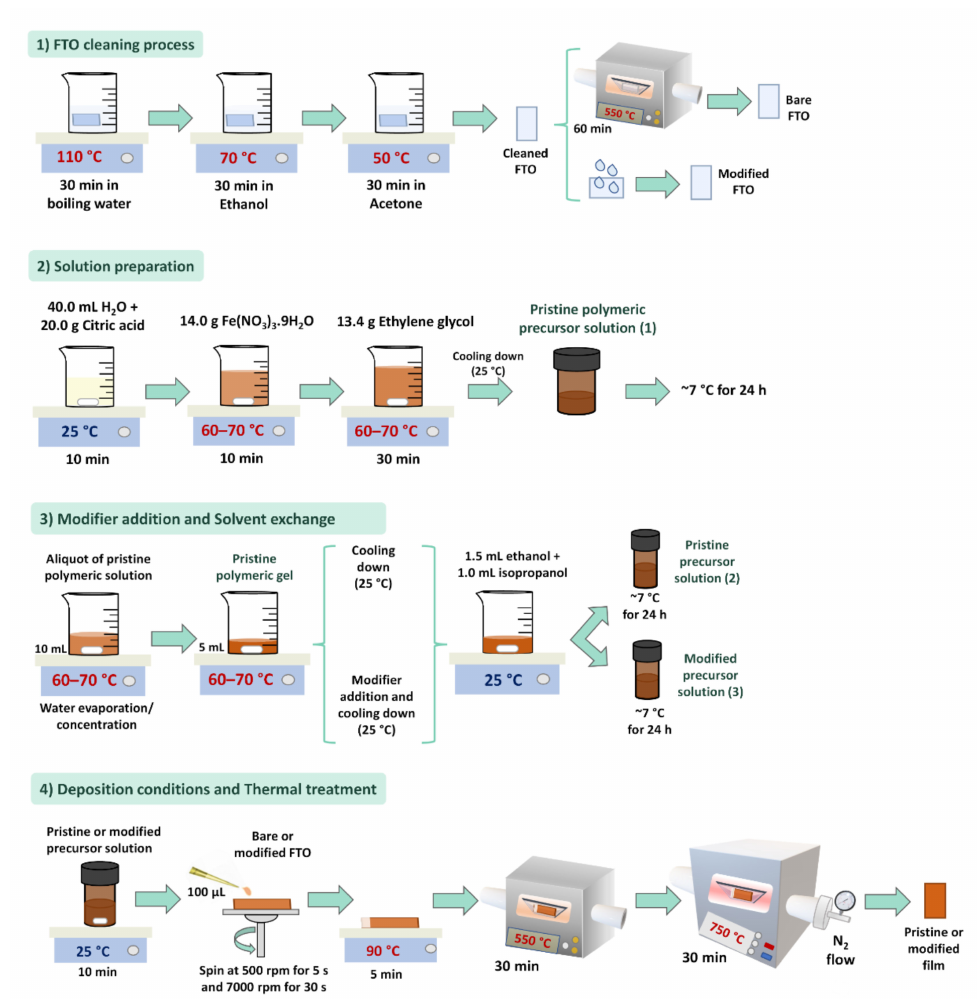
Figure 6. Main steps of the thin film preparation from the polymeric precursor method, optimized to receive different modifiers, minimizing the electron loss at the interfaces. Fluorine-doped tin oxide (FTO) glass substrate corresponds to the commercial substrate; modified FTO represents any chemical surface modification, such as an underlayer coating prior to photocatalyst deposition; solution preparation shows the common hematite synthesis as an example of nanostructured oxide that can be obtained from polymeric precursor route; and modifier addition denotes any element different from those present in the solution preparation that is employed for some optoelectronic